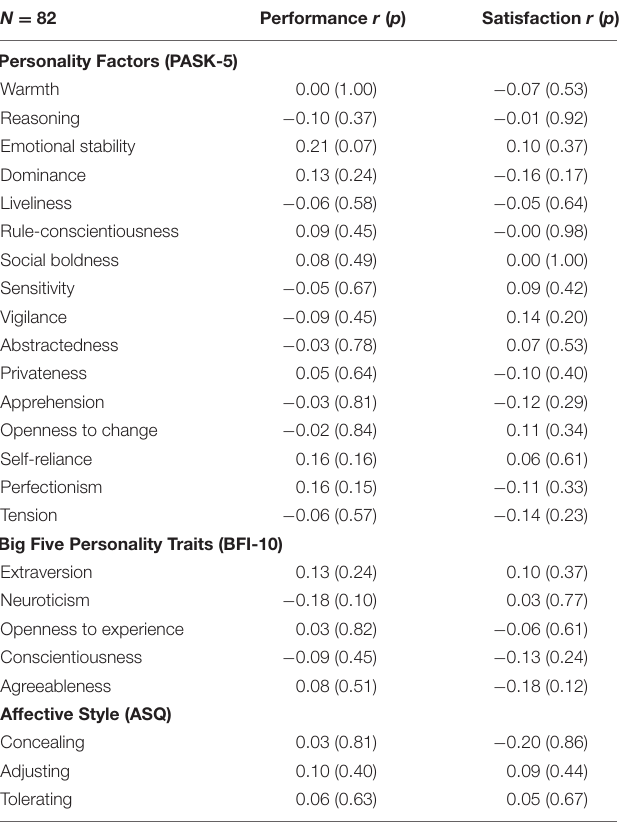
TABLE 2 | Relationship between elite beach volleyball players’ personality, performance, and